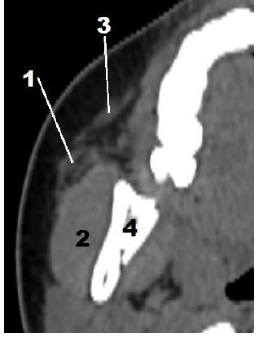
Figure 6. Geodesic map after the buccal fat pad resection and augmentation mentoplasty. The decrease of volume in the check area in front of anterior margin of masseter muscle.